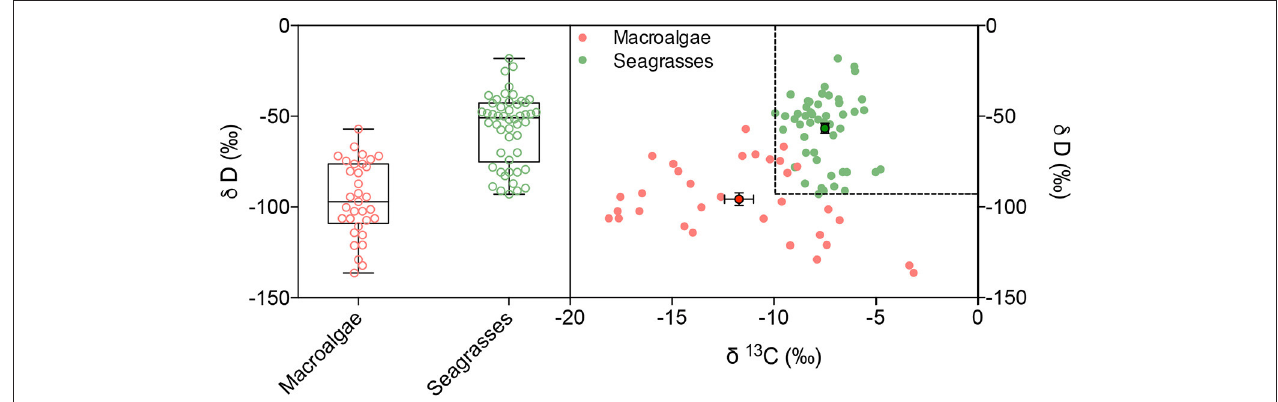
FIGURE 3 | Deuterium stable isotope concentration (left) and the relationship between δ 13 C and δ D (right) on the blades of macroalgae and seagrasses, indicated in red and green, respectively. Dashed lines indicate the minimum values of δ 13 C and δ D for seagrass tissues. Mean ± SE values of δ 13 C and δ D values are shown with dots and error